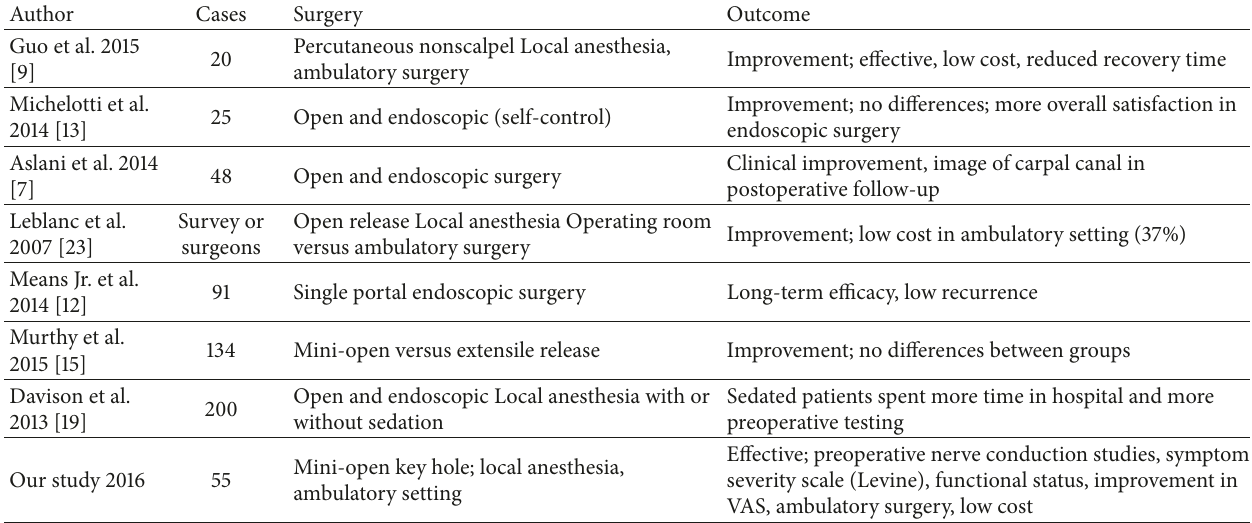
Table 2: Comparative results in summary, of carpal tunnel release in the